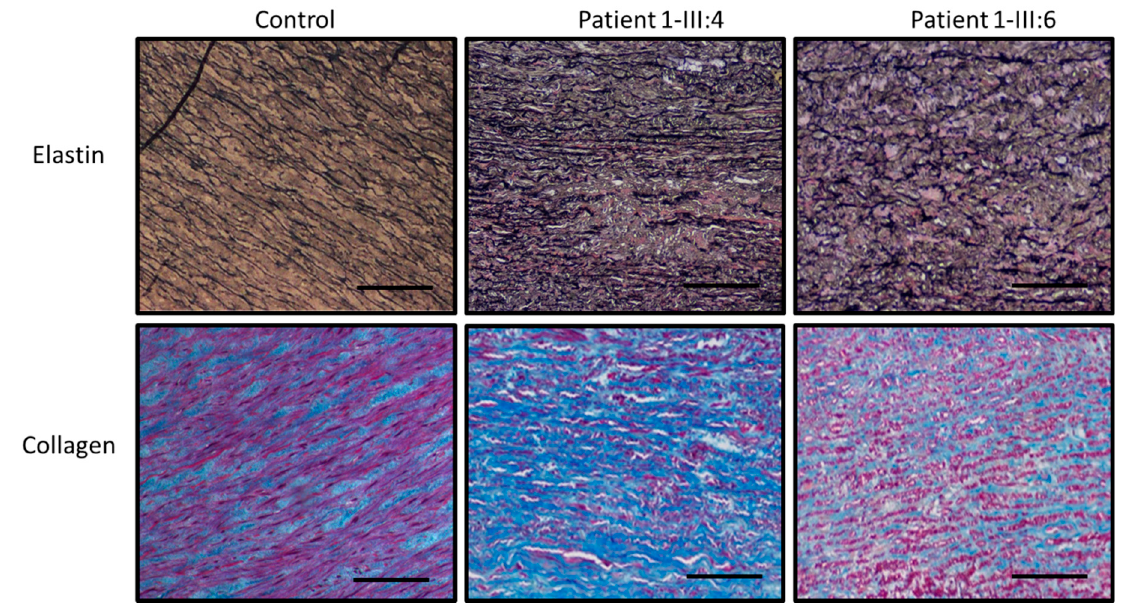
Figure 3. Representative pictures of collagen and elastin stainings performed in a control and two LOX patients, respectively, patient 1-III:4 and 1-III:6. The scale bar represents 100 μ m.